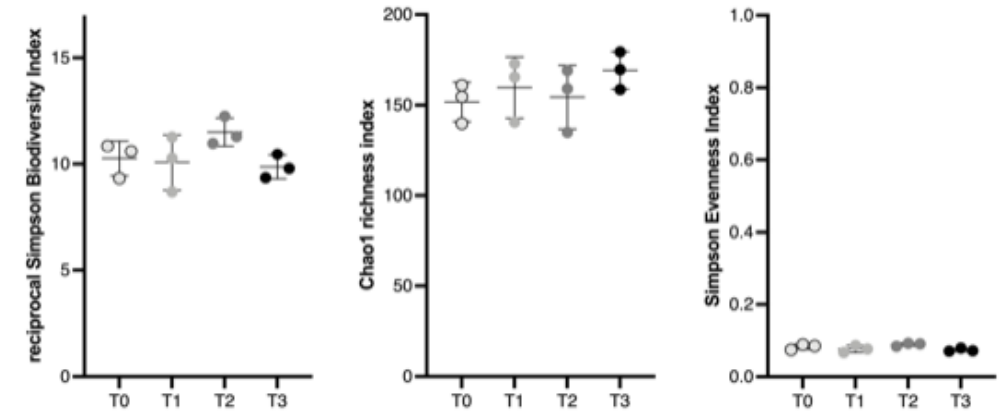
Figure 2. Scatterplots depicting α diversity indices at each step of the fecal manipulation procedure (T 0–3 ). Each dot represents a subsample (A, B, C). Bacterial intrinsic diversity was deduced from the reciprocal Simpson biodiversity index, bacterial genus richness from the Chao1 index and bacterial genus evenness from Simpson’s index. No significant difference was found between groups regarding the reciprocal Simpson index, population richness and Simpson-derived evenness based on a Friedman test. Horizontal lines represent the mean and error bars indicate the 95% CIs for each time point.